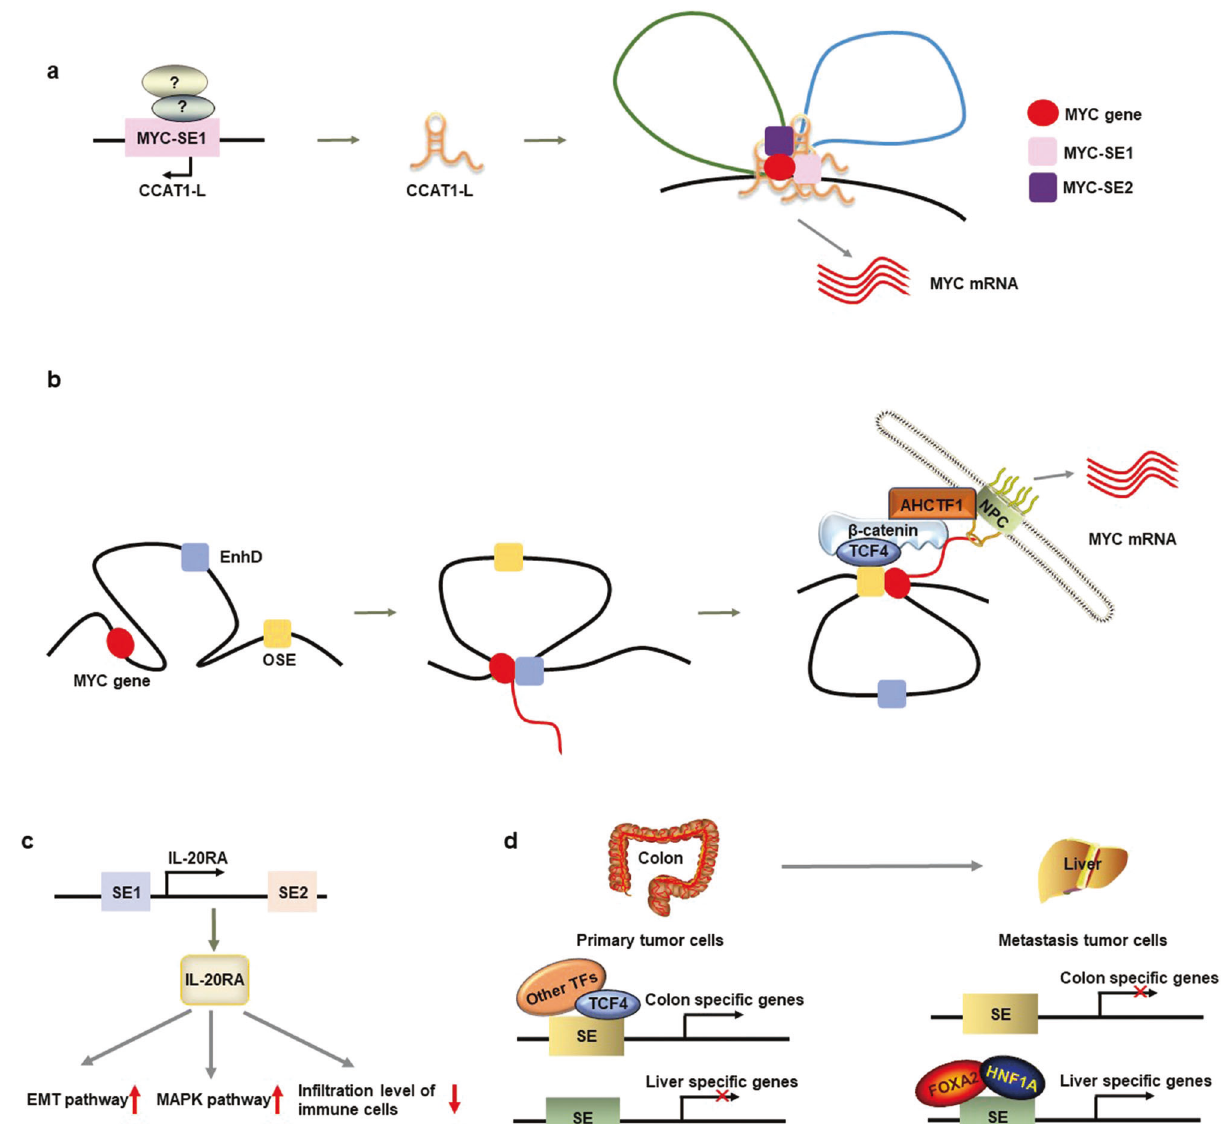
Fig. 2 The oncogenic roles and regulatory mechanisms of SEs in colorectal cancer. a The long noncoding RNA CCAT-1L, derived from an MYC SE, mediates the interaction between SEs and the promoter of the MYC gene, regulating its transcription in collaboration with SEs. b AHCTF1 together with the β -catenin-TCF4 complex connects nucleoporins to the OSEs of the MYC gene, facilitating transcript export into the cytoplasm. c IL-20RA, transcriptionally regulated by several SEs, participates in oncogenic and immune pathways in CRC. d SEs participate in the liver metastasis of CRC via organ-speci fi c transcription